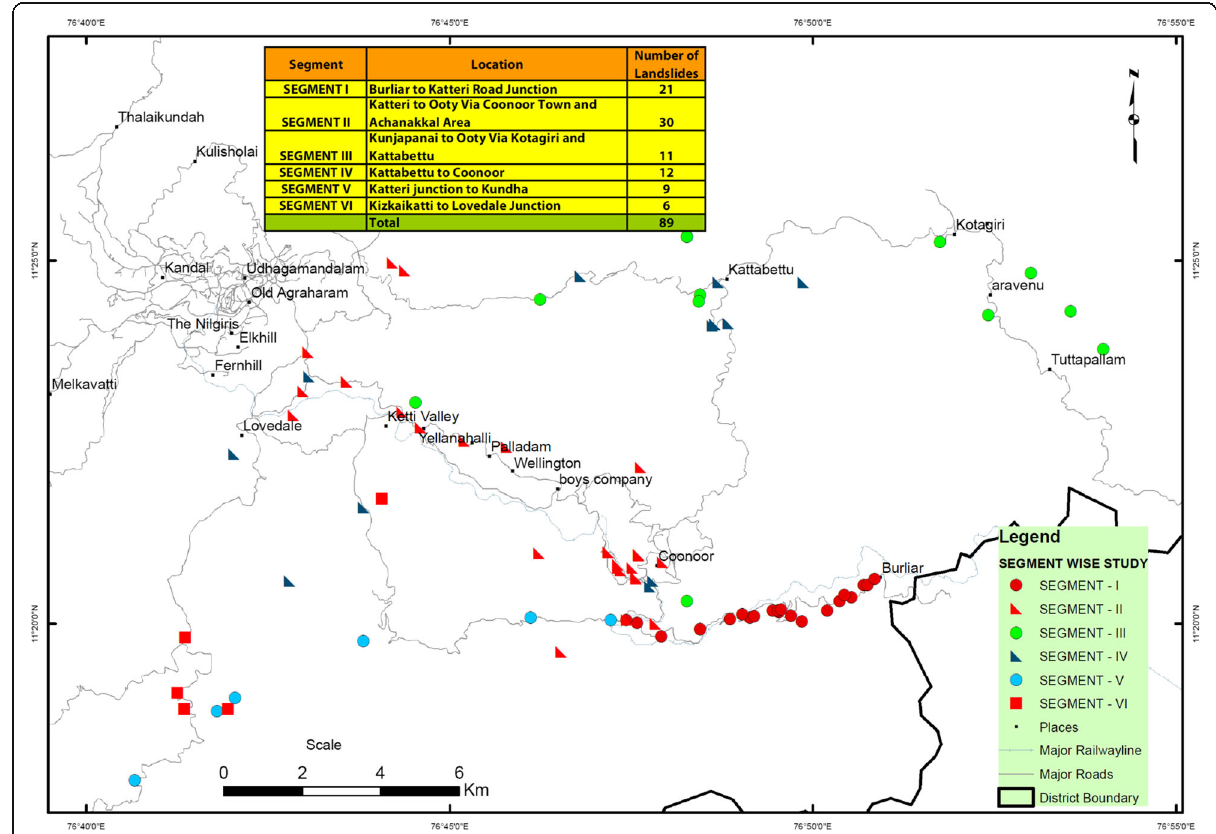
Fig. 5 Segment wise location of landslides considered for